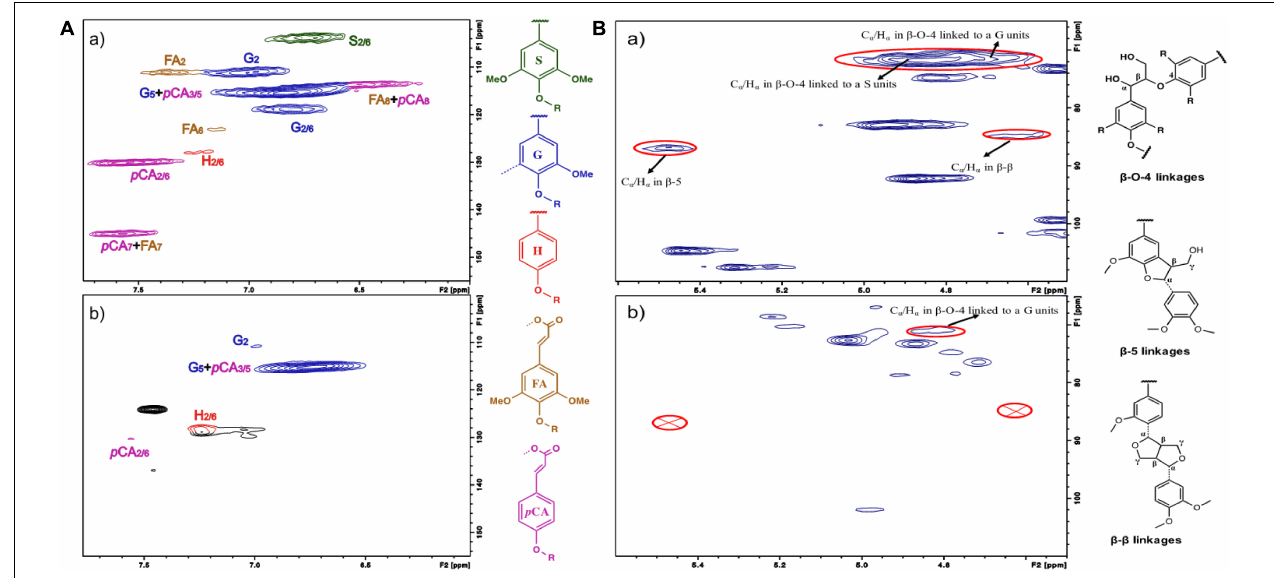
FIGURE 4 | 2D HSQC NMR spectra for (a) the ball milled lignin from raw switchgrass and (b) lignin from F2O processed switchgrass. (A) Aromatic regions. S, syringyl; G, guaiacyl; H, p-hydroxyphenyl; FA, ferulate; pCA, p-coumarate. (B) Aliphatic